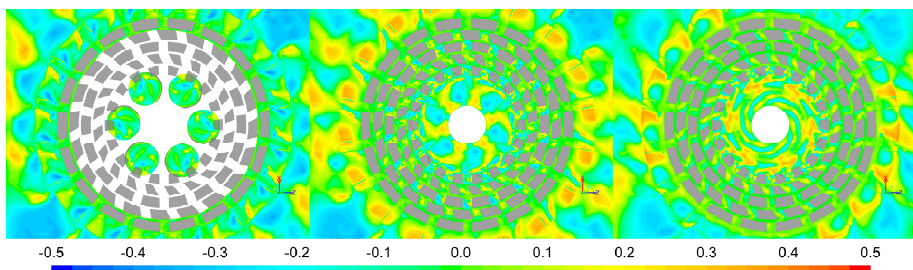
Figure 6. Dimensionless parameter R ′ N at 6000 rpm for the same planes as in Figure 4.